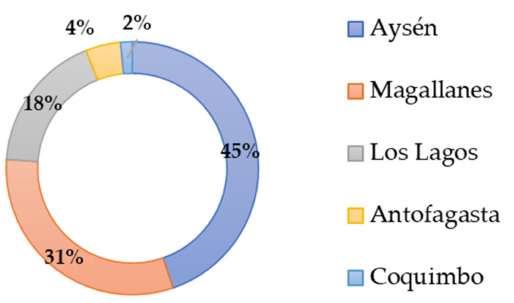
Figure 8. Regional distribution of Alexandrium HABs events in